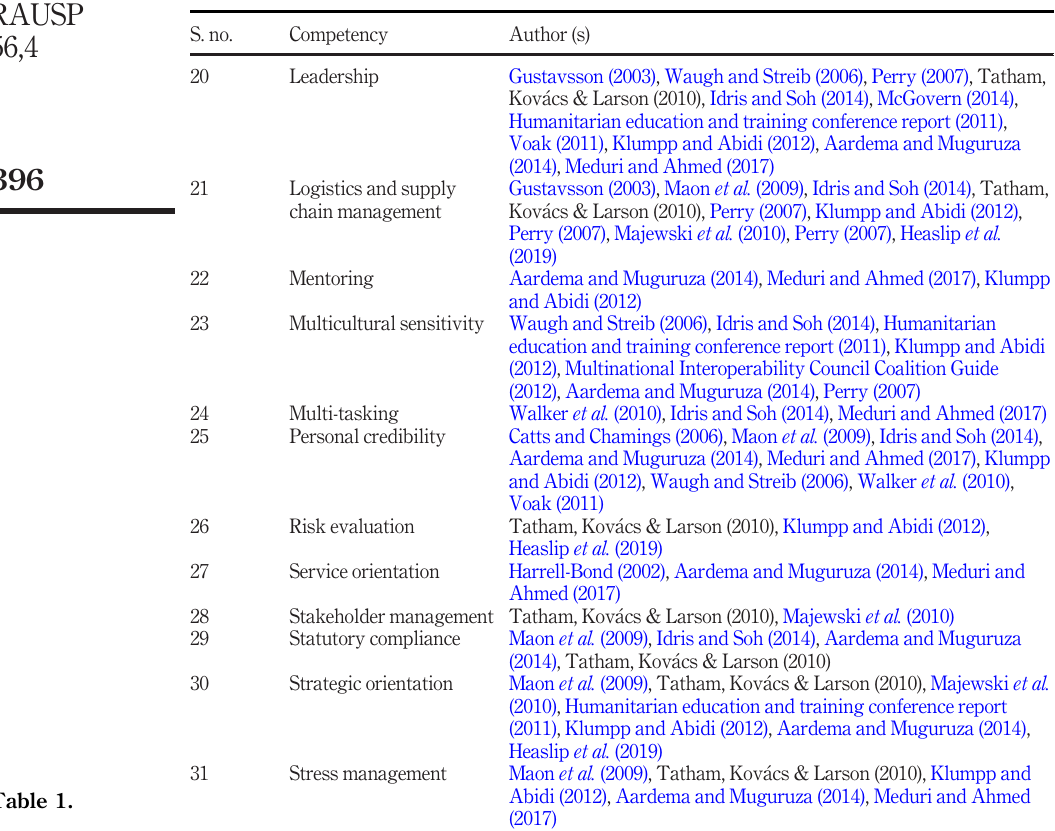
competencies required by the relief organizations in India through the job advertisements posted in ReliefWeb (humanitarian information portal between March – July 2018). The keywords used for the search were “ humanitarian logistician, ” “ emergency relief worker, ” “ fi eld volunteers, ” etc., and the results were fi ltered by country name – “ India. ” Out of the 73 job advertisements that resulted, 44 were chosen for the study from different organizations to eliminate redundancy. The 44 job advertisements were given to 23 coders who were identi fi ed and showed interest in the task. They were all knowledgeable about the competency frameworks. While roping them into the project, they were trained by the authors on identifying competencies from job advertisements in a 6-h training program, in which we explained the scope and objectives of the project. When the job advertisements used for the current study were shared, a sample coding of an advertisement (which was not among the 44 advertisements used for the study) was also shared. The coders were briefed through telephonic, online or personal conversation and coded the job advertisements for the competencies required by the relief organizations into 109